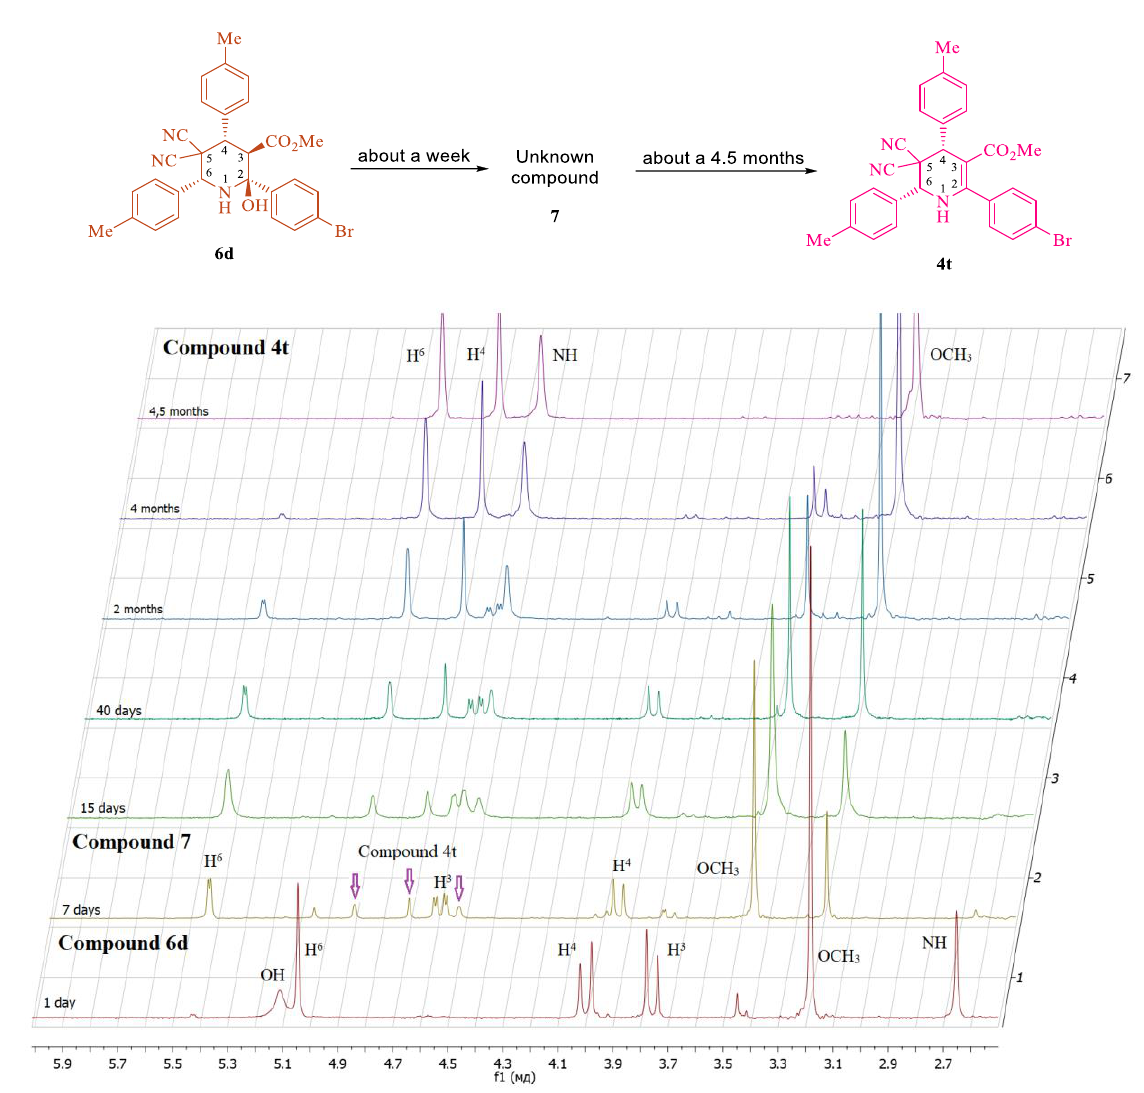
Figure 4. 1 H NMR monitoring of the characteristic signals of 6d , unknown compound 7 and 4t over 4.5 months.